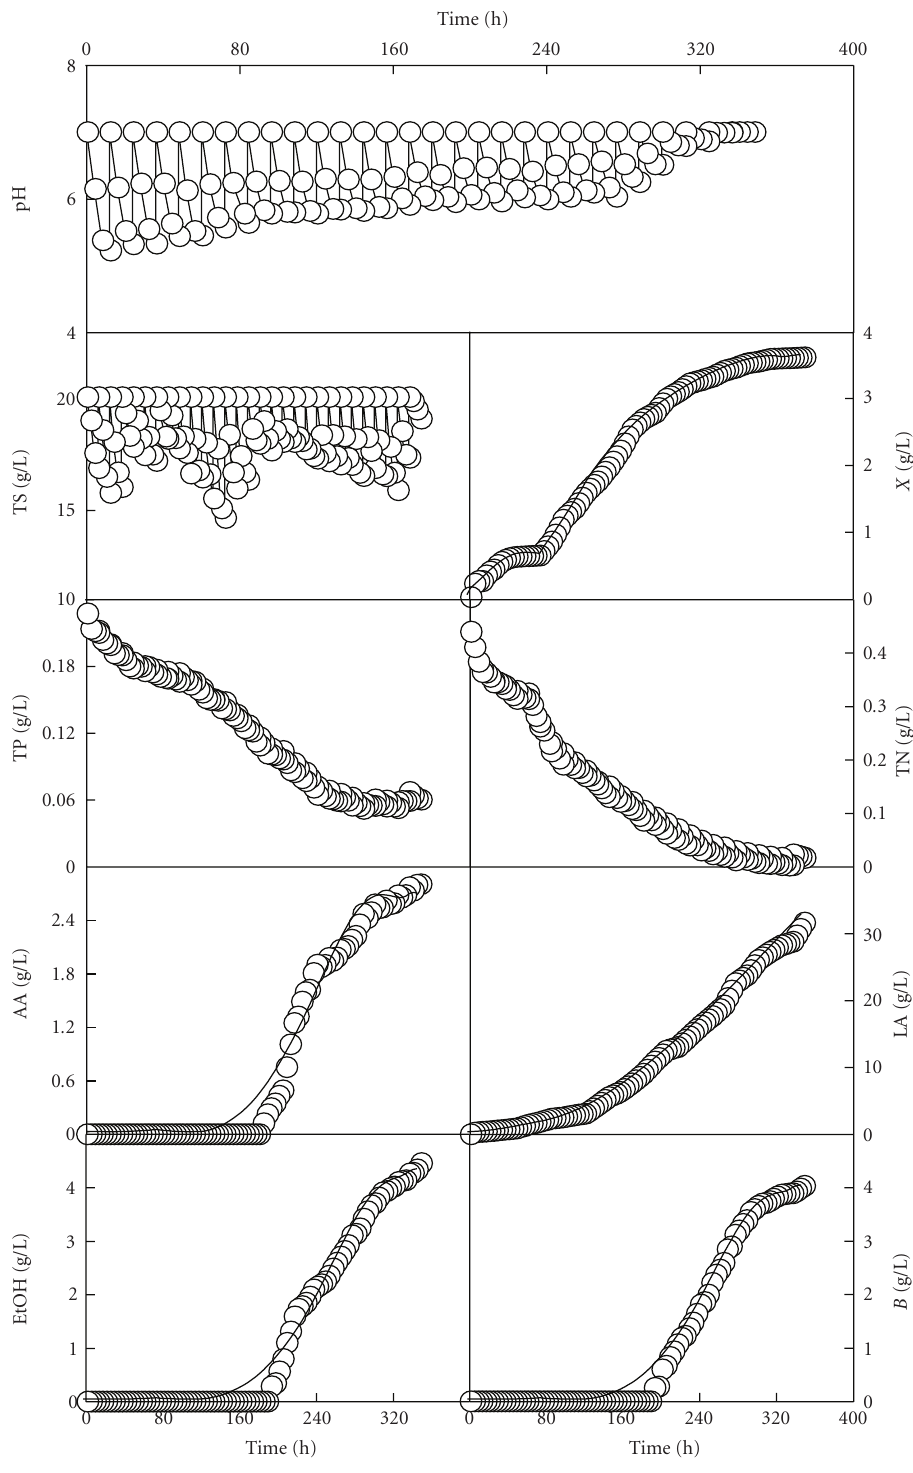
Figure 4: Time course of the realkalized fed-batch culture of Ent. faecium CECT 410 on whey with feeding with concentrated whey and a 400g/L concentrated lactose (fed-batch fermentation II). Notations are as in Figures 1 and 3. Data reported are means ± standard deviations of three replicates. The solid lines drawn through the experimental data of biomass and lactic acid were obtained according to the models (A.6) and (A.7), respectively. The solid lines drawn through the experimental data for AA, EtOH, and B were obtained according to the model